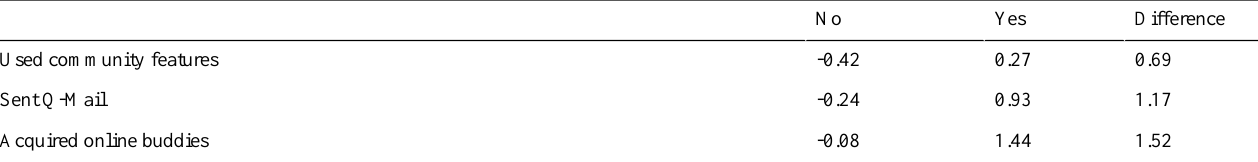
DifferenceYesNo